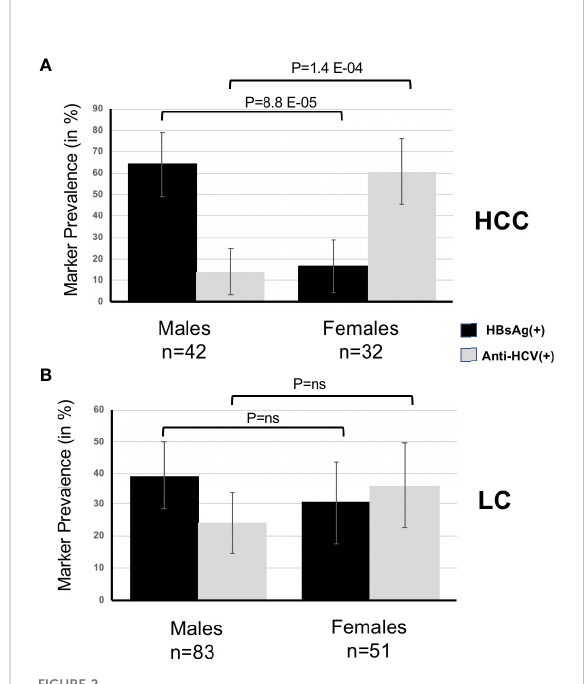
FIGURE 2 (A) , Prevalence of HBsAg and anti-HCV according to sex in HCC. (B) , Prevalence of HBsAg and anti-HCV according to sex in LC.